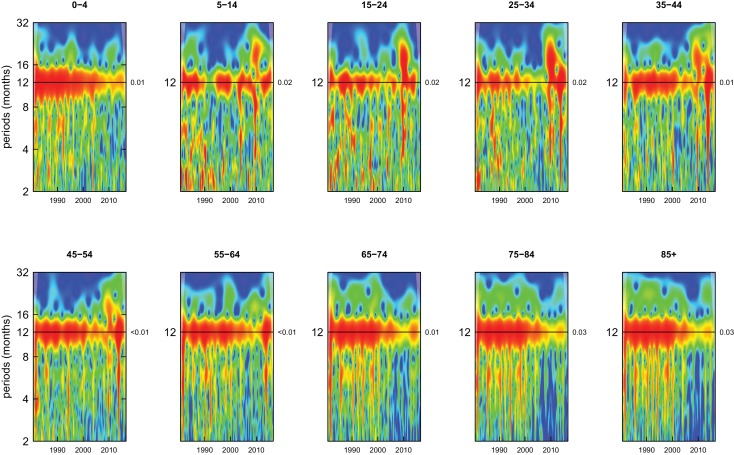
Wavelet power spectra for national time series of respiratory infection death rates for 1980–2016, by age group for males.Wavelet power values increase from blue to red. The shaded regions at the left and right edge of each box indicate the cone of influence, where spectral analysis is less robust. P-values for the presence of 12 month seasonality are to the right of each figure at the 12 month line.